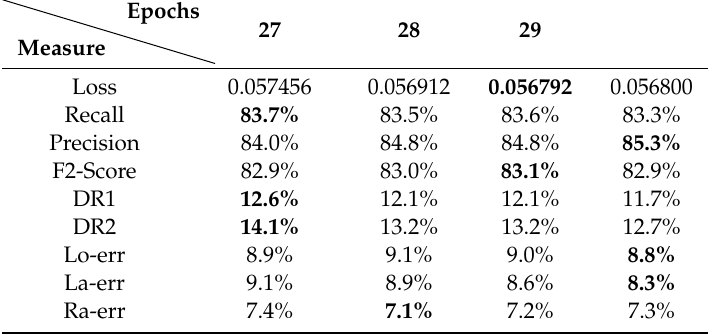
Table 6. The recognition result between 26 and 29 training time (bold in the table means the best results on this evaluation